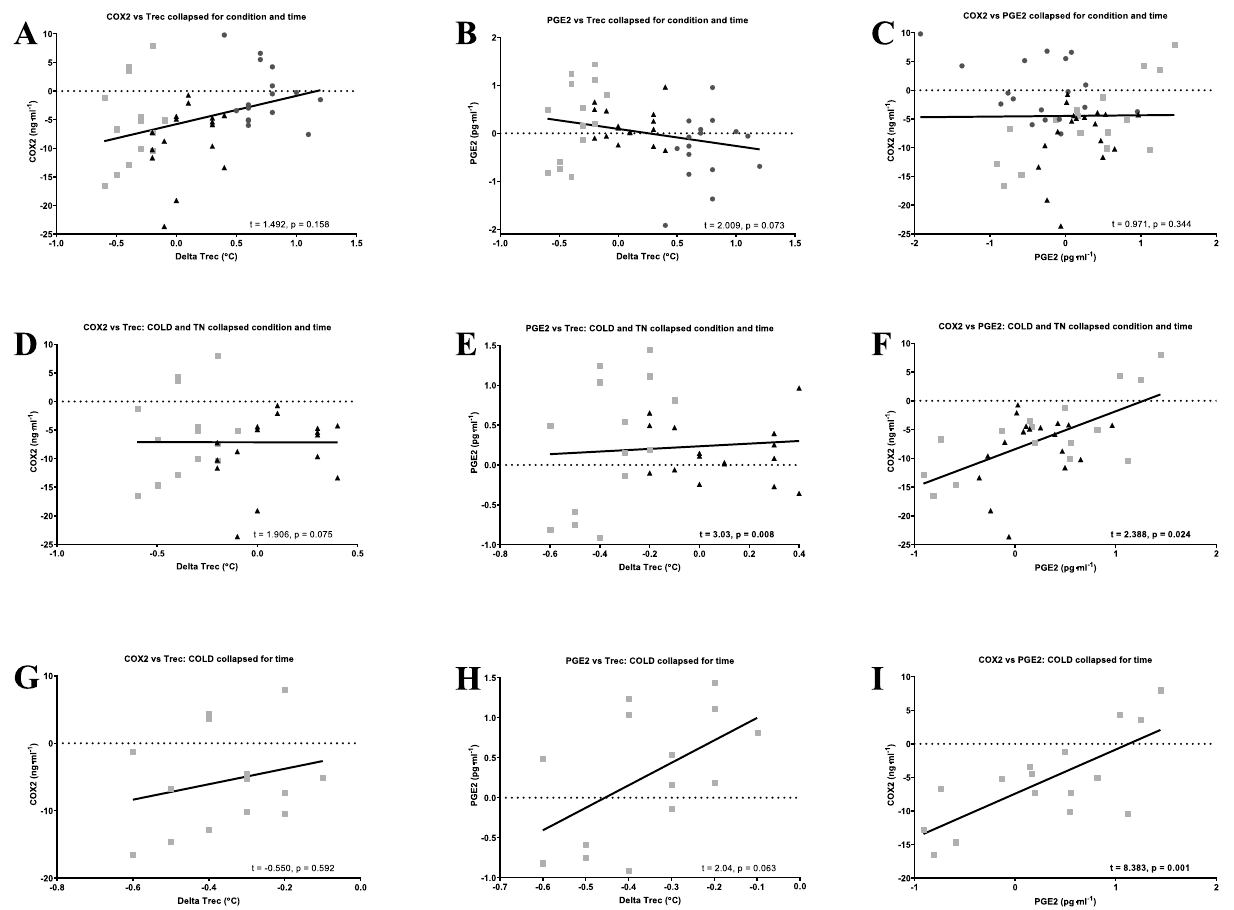
Figure 4. Random coefficient models: the relationships across all conditions and the analysis including the COLD condition are presented (n = 8). Significance of relationship is detailed in each panel; significant relationships are highlighted in bold and italicized. ( A ) COX2 vs Trec collapsed by condition and time. ( B ) PGE2 vs Trec collapsed by condition and time. ( C ) COX2 vs PGE2 collapsed by condition and time. ( D ) COX2 vs Trec: COLD and TN collapsed by condition and time. ( E ) PGE2 vs Trec: COLD and TN collapsed by condition and time. ( F ) COX2 vs PGE2: COLD and TN collapsed by condition and time. ( G ) COX2 vs Trec: COLD collapsed by time. ( H ) PGE2 vs Trec: COLD collapsed by time. ( I ) COX2 vs PGE2: COLD collapsed by